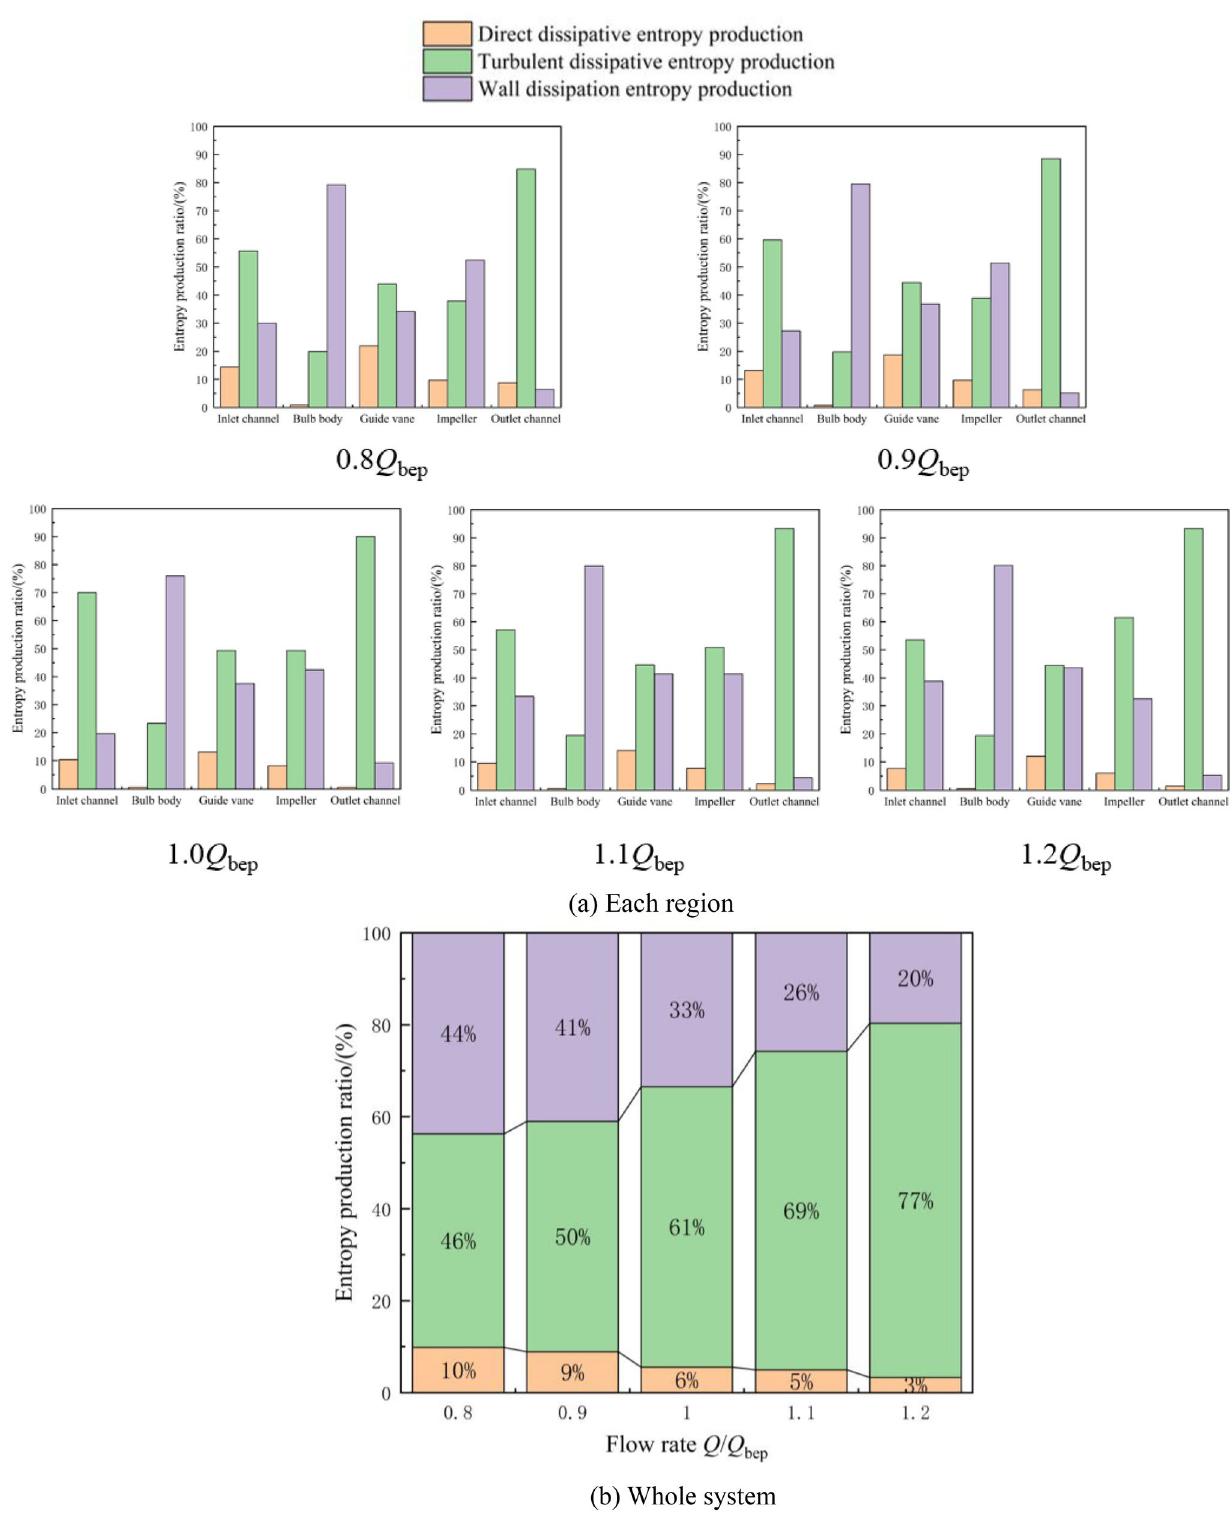
Figure 8. Distribution characteristics of three types of entropy generation under different flow